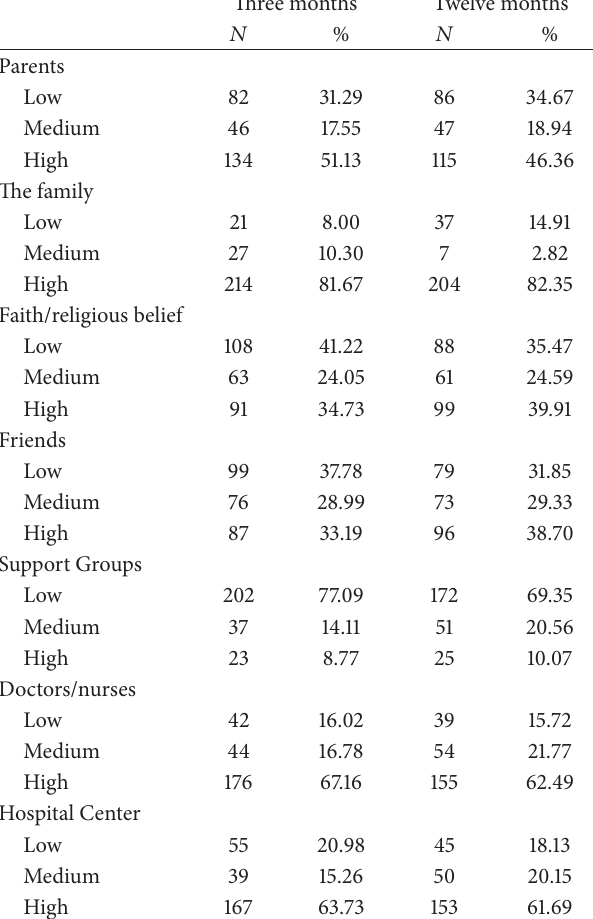
Table 5: Main factors in the choice of MS